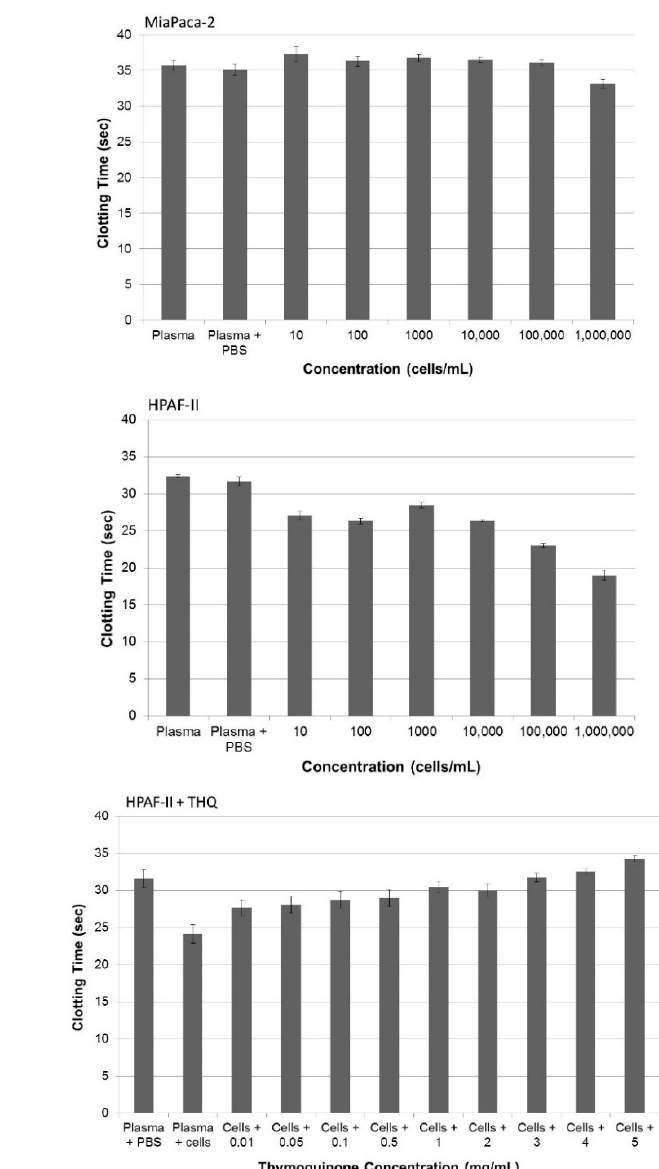
Figure 3. THQ reverses coagulation mediated by tissue factor (TF) present on pancreatic cancer cells. ( a ) Flow cytometry analysis of TF on pancreatic cancer cells. Data in the top panels are from MiaPaCa-2 cells, and data in the bottom panels are from HPAF-II cells. The left panels serve as a control from cells unstained for TF, and the right panels are from cells stained with TF-antibody, followed by PE-conjugated secondary antibody. The top right panel shows the absence of TF on MiaPaCa-2 cells. Presence of TF on HPAF-II cells is confirmed by the TF staining on HPAF-II cells (bottom, right panel). Approximately 98% of HPAF-II cells were positive for the presence of TF; ( b ) MiaPaCa-2 cells do not cause coagulation of plasma. The coagulation time measured with aPTT assay did not show any change in the presence of an increasing number of MiaPaCa-2 cells; ( c ) the coagulation time measured with aPTT assay showed that HPAF-II cells can decrease the coagulation time. Both t -test, as well as ANOVA with post hoc (Tukey), showed that there was no significant difference in the clotting time between the plasma and plasma with PBS. Addition of cells (10 to 10,000) in each case significantly ( p < 0.001) reduced the clotting time compared to PBS-plasma; ( d ) THQ reversed the coagulation induced by HPAF-II cells. To 1 × 10 6 HPAF-II cells, THQ was added in increasing concentration, from 0.01 mg/mL to 5 mg/mL. Both t -tests, as well as ANOVA with post hoc (Tukey), showed that THQ at each concentration (0.01 to 5 mg/mL) significantly ( p < 0.001) reduced the clotting time compared to plasma + cells with no THQ. The experiments were performed three times in triplicate. Error bars show the standard deviations of the mean values.